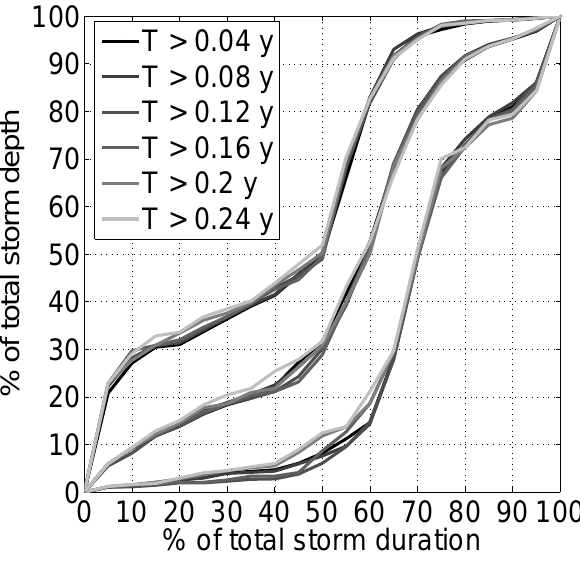
Fig. 5. Comparison of Huff curves, considering 3rd quartile summer storms for different thresholds on the secondary return period T